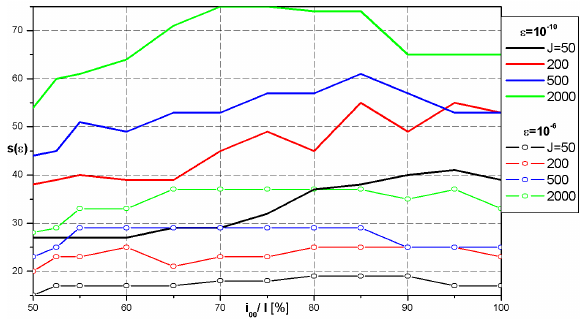
Figure 13. Number of iterations on the size of Dirichlet area in the mixed boundary-value